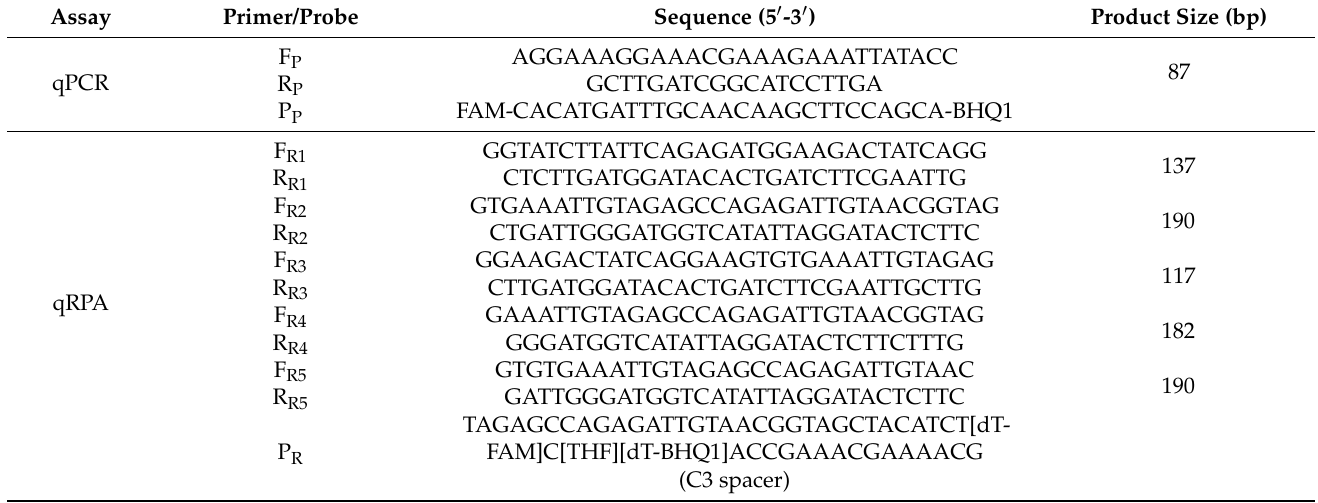
Table 1. Primer and probe sequences of DIV1-qPCR, DIV1-qRPA, and DIV1-RPA-SYBR Green I